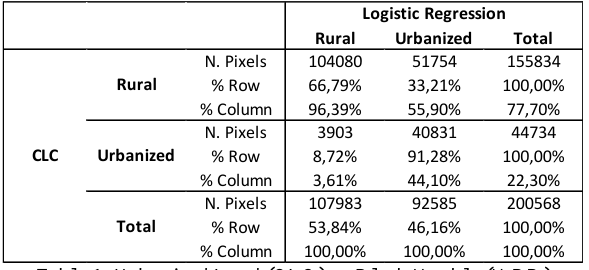
Figure 6. Black Marble (MRB)